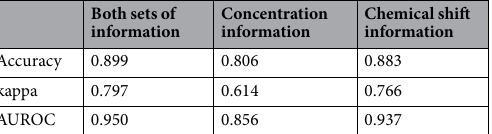
Table 3. Adding chemical shift information to concentration information provides the best classification of samples in the MTBLS374 dataset. Several quality indicators of the models generated only with concentration information, only with chemical shift information and with both sources of information are